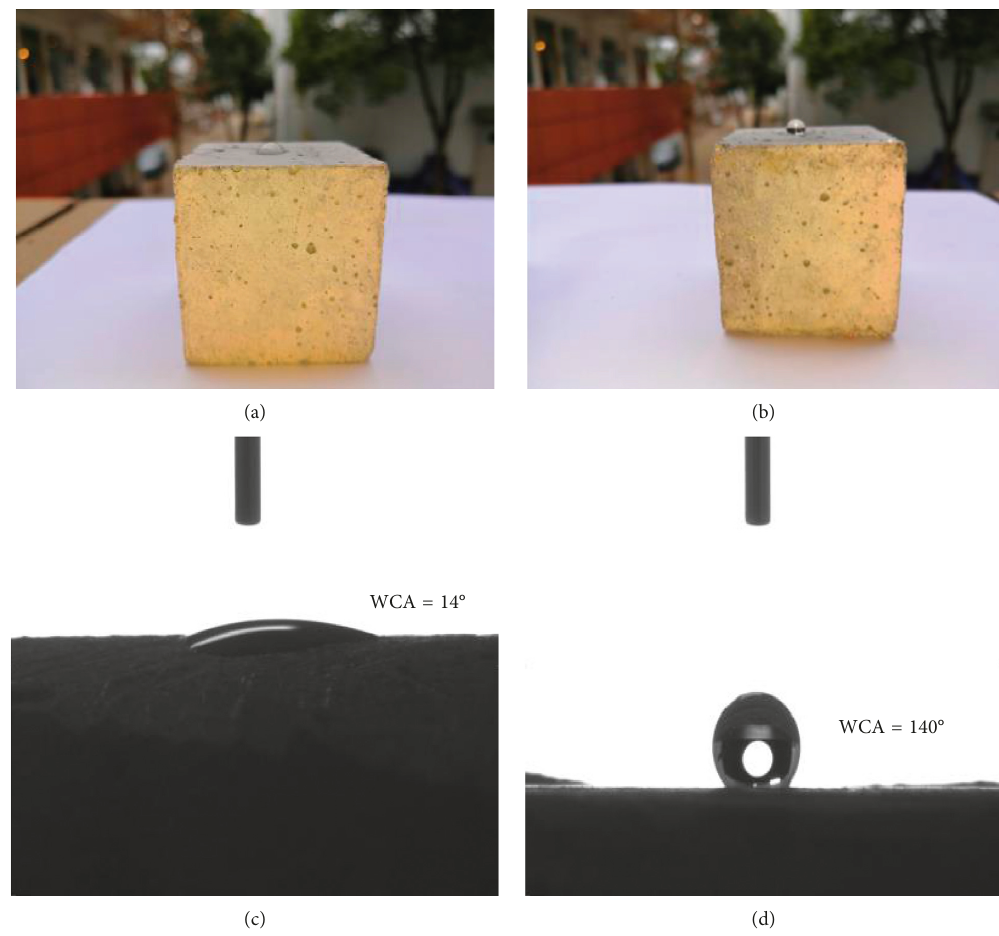
Figure 3: Water contact angles on the surface of mortar specimens: (a) baseline sample, (b) hydrophobic sample, (c) WCA of the baseline sample, and (d) WCA of the hydrophobic